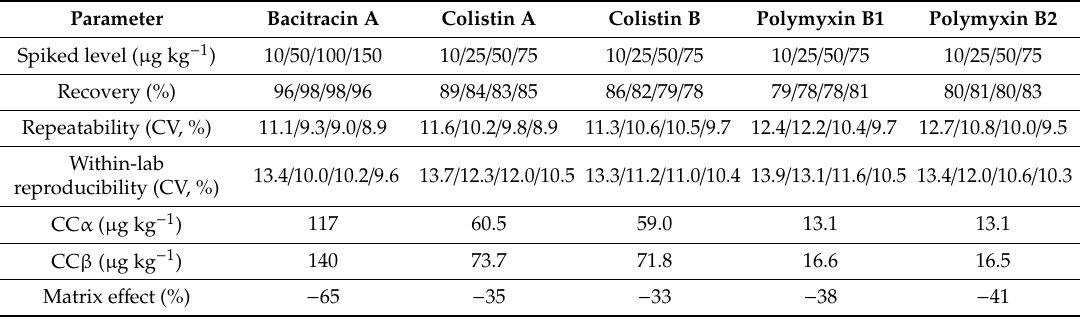
Table 2. Validation results of the method for the determination of polypeptides in milk.